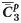
Average outflow facility C¯3p as a function of intraocular pressure and for a range of values of α.